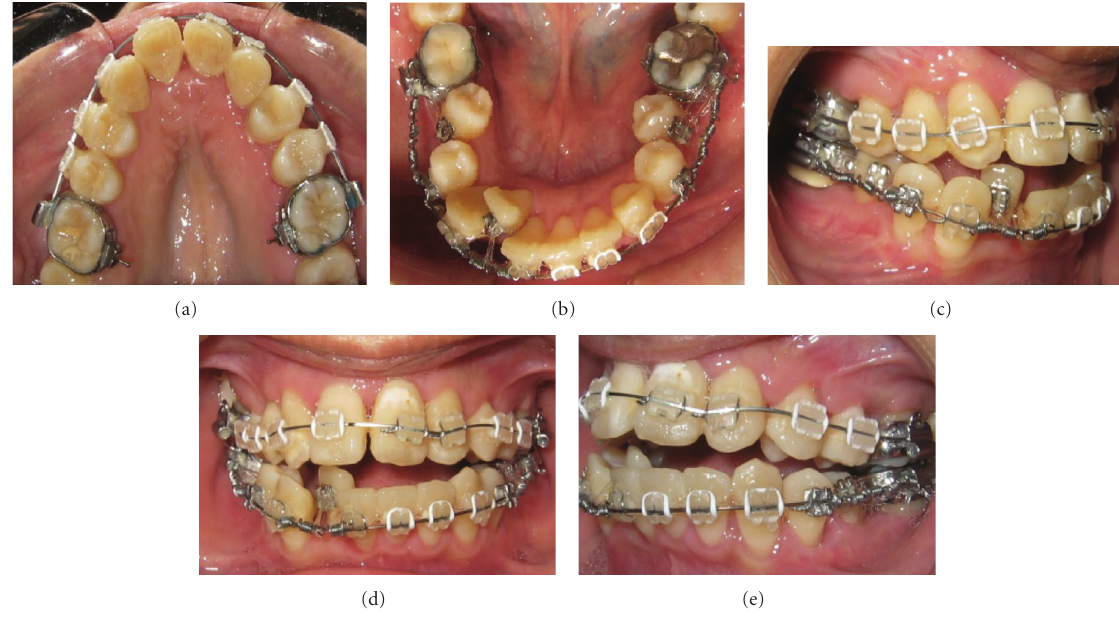
Figure 6: Intraoral photographs 2 weeks after